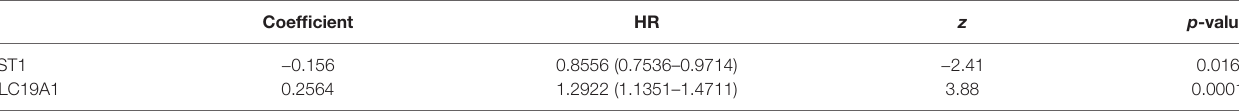
TABLE 3 | LST1 and SLC19A1 in the multiple stepwise Cox regression analysis.